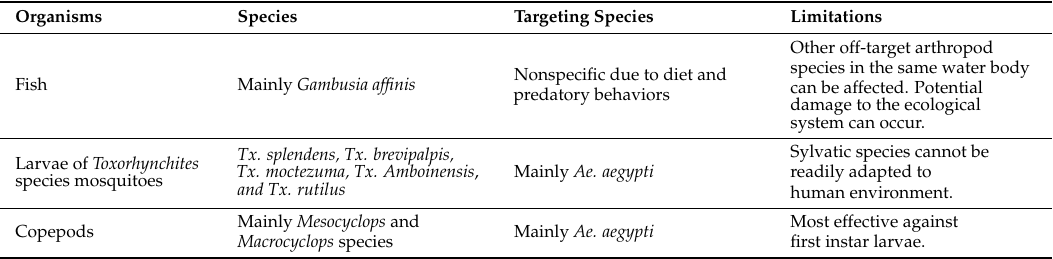
Table 1. Predators of mosquito larvae as tools for biological control of